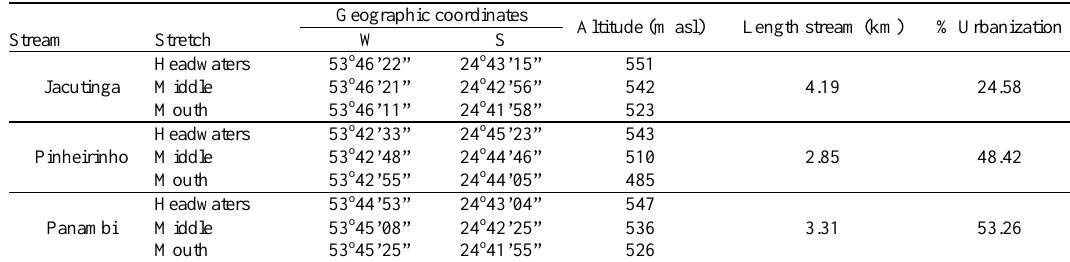
Table 1. Stretches sampled in three streams located in urban area in the city of Toledo, State of Paraná, southern Brazil, as well as their geographic coordinates and level of